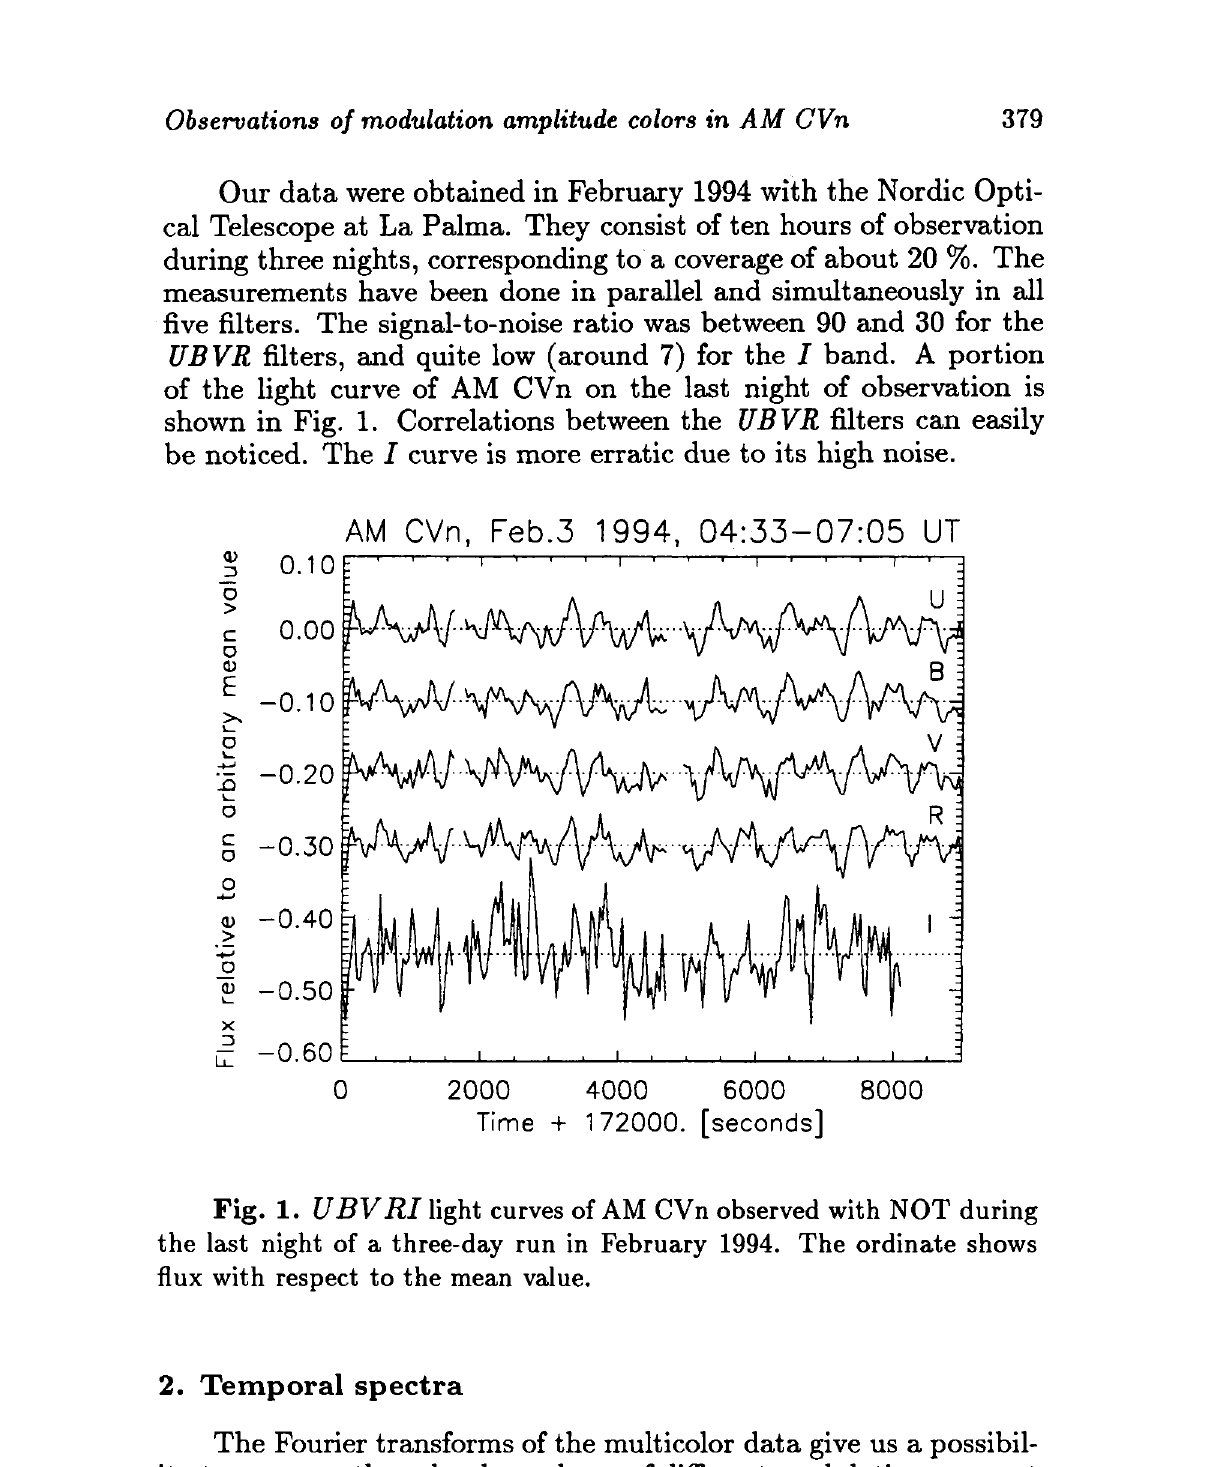
Fig. 1. UBVRI light curves of AM CVn observed with NOT during flux with respect to the mean